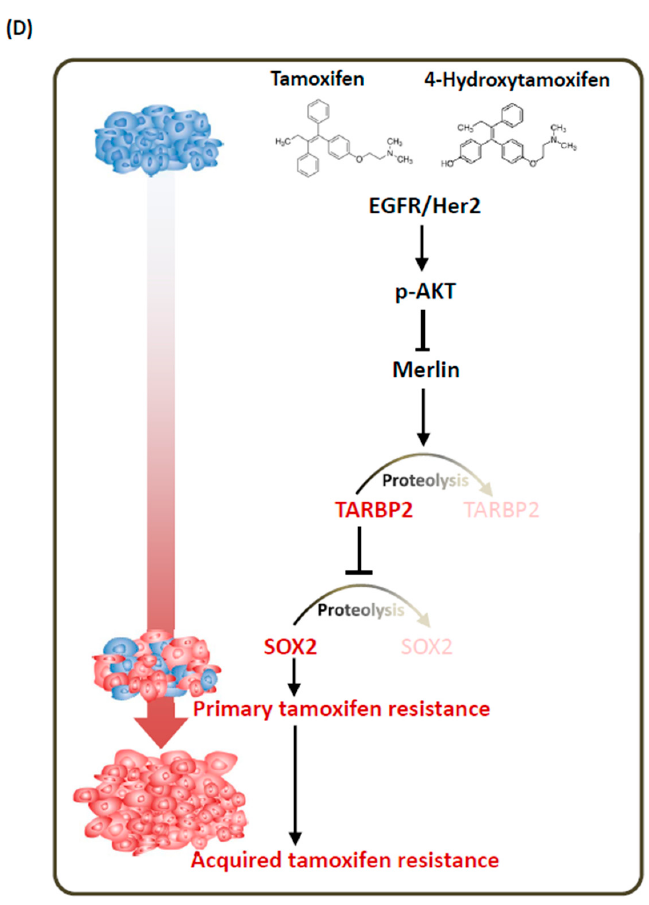
Figure 7. Both SOX2 and TARBP2 expression are elevated in hormone therapy-resistant tumor cells. ( A ) The correlation of SOX2 expression with the overall survival of ER-positive breast cancer patients was analyzed and downloaded using Kaplan-Meier Plotter (http://kmplot.com/). ( B , C ) Association of SOX2 expression and hormone therapy resistance in breast cancer tissues. Representative serial sections of Figure 1B showed images of SOX2 IHC in primary tumors and tumors in lymph nodes in cases of cancer recurrence ( B ). Scale Bar: 100 uM. Statistics of SOX2 protein expression levels in primary tumors and metastatic tumor cells in cases of cancer recurrence ( C ). ( D ) Resistance mechanism for tamoxifen–induced TARBP2-SOX2 in breast cancer.